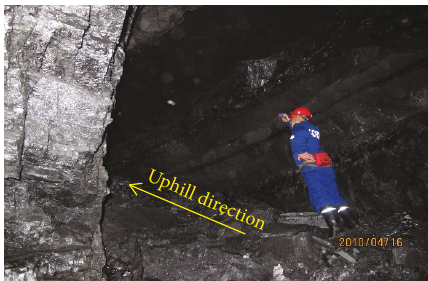
Figure 11: Uphill direction in the No.1 abandoned